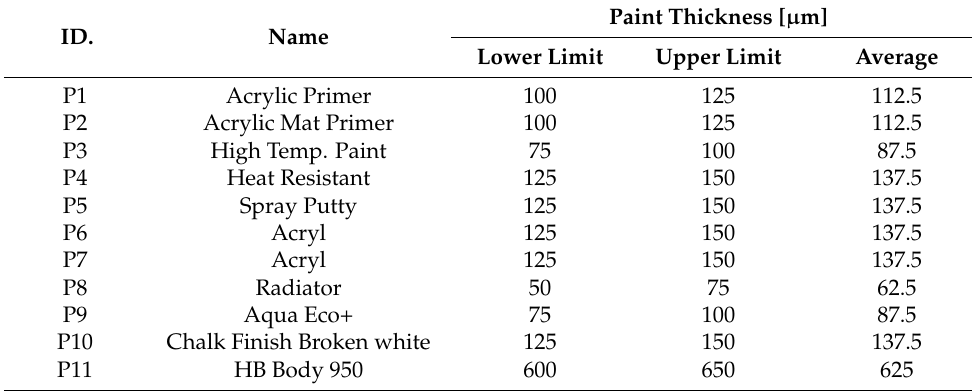
Table 5. Results of the wet paint thickness